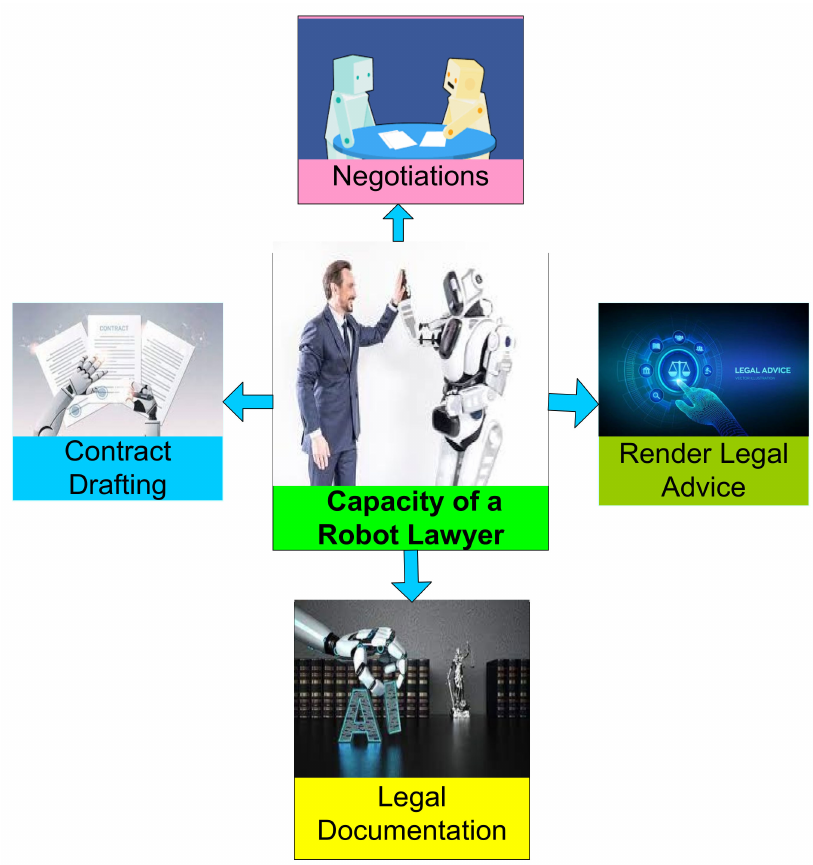
Figure 4. The capacity of a Robot Lawyer.